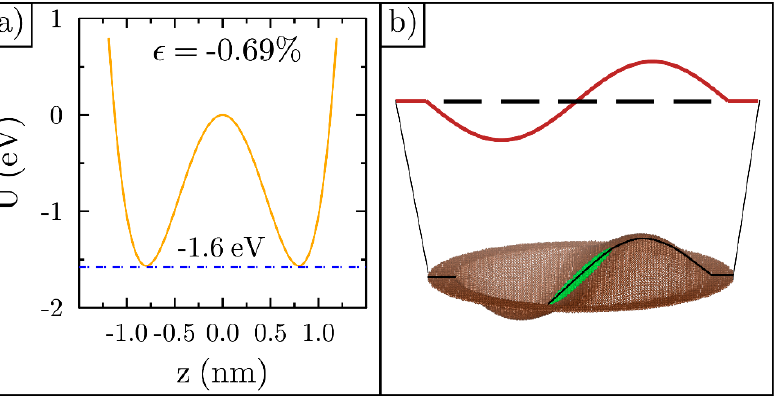
Figure 5. Potential energy and ripple shape: ( a ) Double-well potential for strain of − 0.7%; ( b ) Illus- tration of a possible ripple shape during inversion, along with its cross-section.